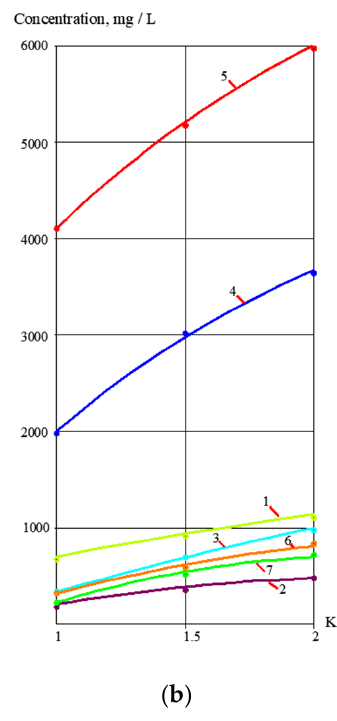
Figure 12. Treatment of reject after sludge dewatering with nanofiltration membranes on the first stage of membrane facility (Figure 2b): ( a ) dependencies of different ion and impurity concentration values on K in concentrate of nanofiltration membranes; ( b ) dependencies of different ion and impurity concentration values on K in nanofiltration membrane permeate: 1—chlorides; 2—sulphates; 3—calcium; 4—bicarbonates; 5—TDS; 6—COD; 7—aluminum.